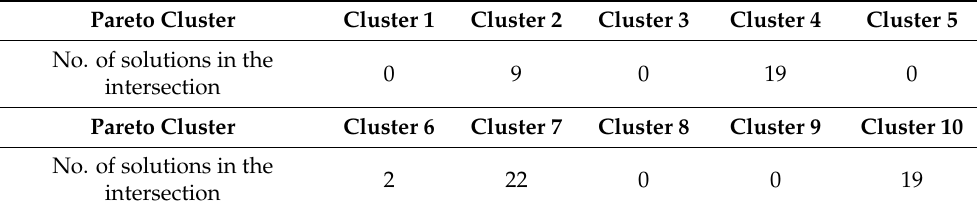
Table 2. Number of solutions in the intersection between cluster 5 of MWFSM-DPC and the Pareto clusters.